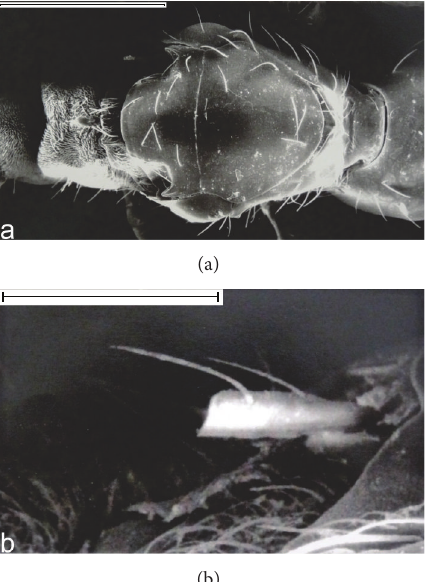
Figure 9: (a) Bruchopria hexatoma female dealate in dorsal view. (b) Solenopsis richteri. Scale: 1 mm.